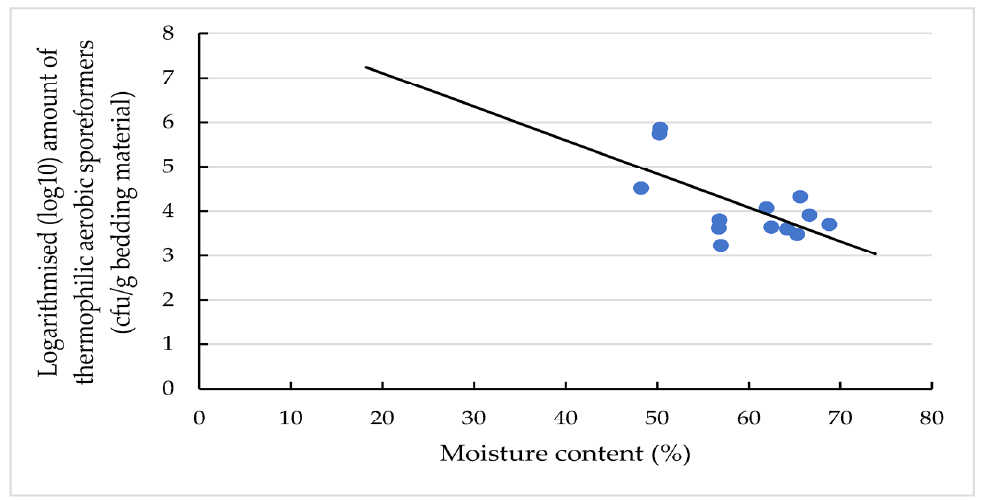
Figure 9. Relationship between thermophilic bacteria and moisture content in composting bedding material; y = − 0.08x + 8.62 (R 2 = 0.34). Source: Taken from Giambra et al., 2021 [23].